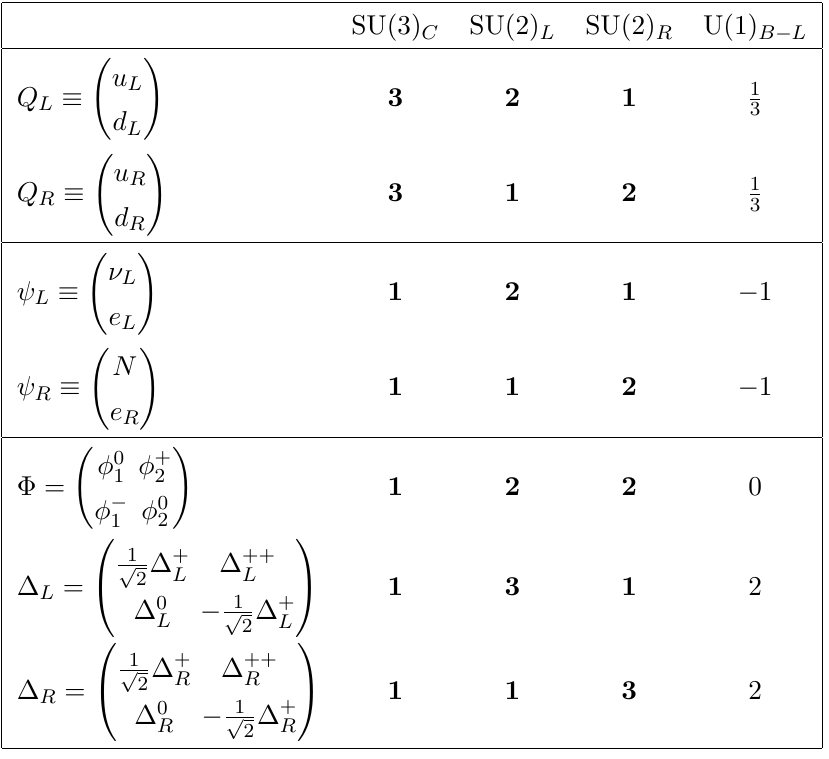
Table 1 . Particle content of left-right symmetric model based on the gauge group SU(3) C (cid:10) SU(2) L (cid:10) SU(2) R (cid:10) U(1) B (cid:0) L